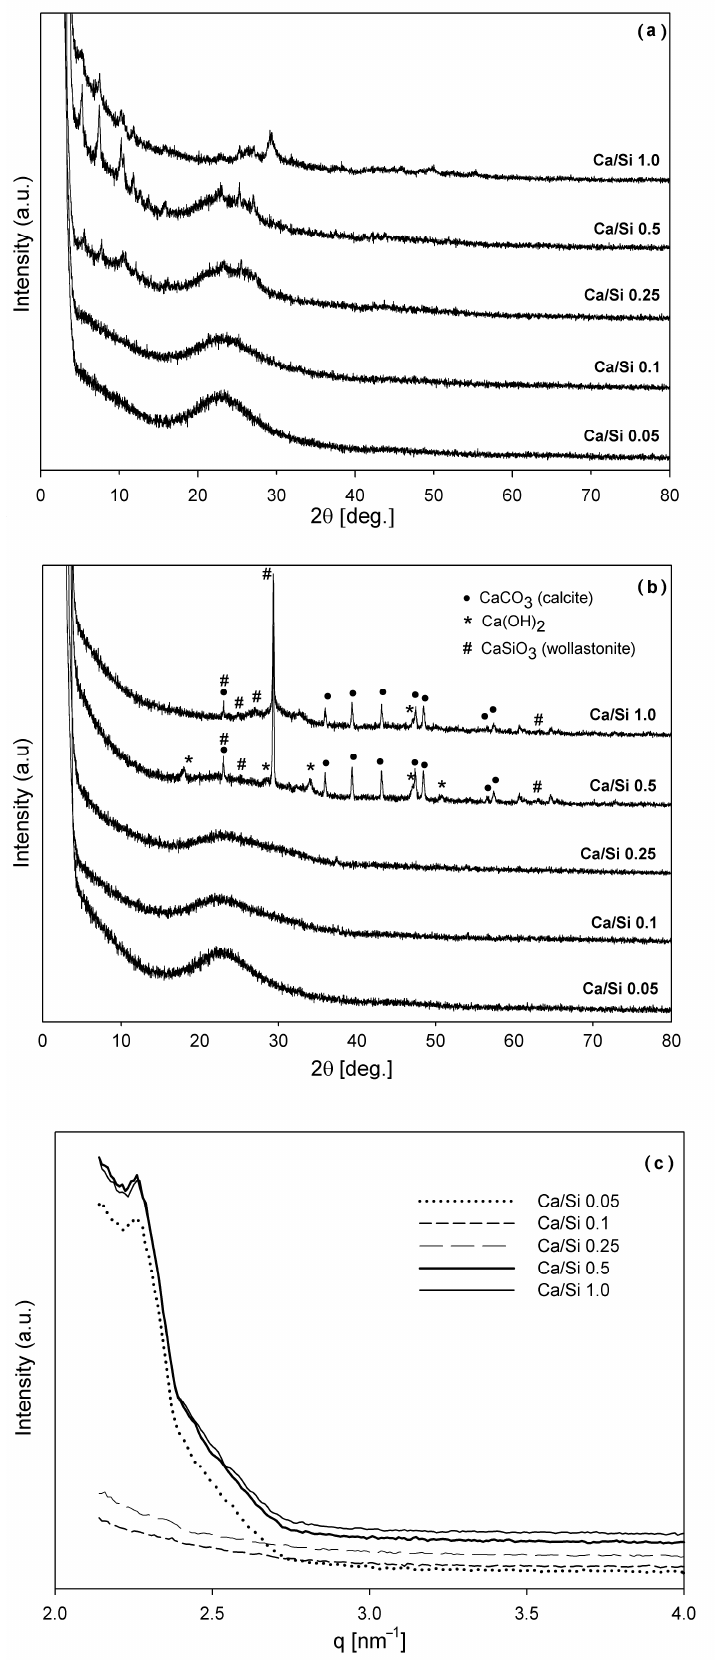
Figure 1. XRPD patterns of Ca/Si systems: ( a ) before calcination; ( b ) after calcination at 600 ◦ C in oxygen atmosphere; ( c ) SAXS scattering of calcined